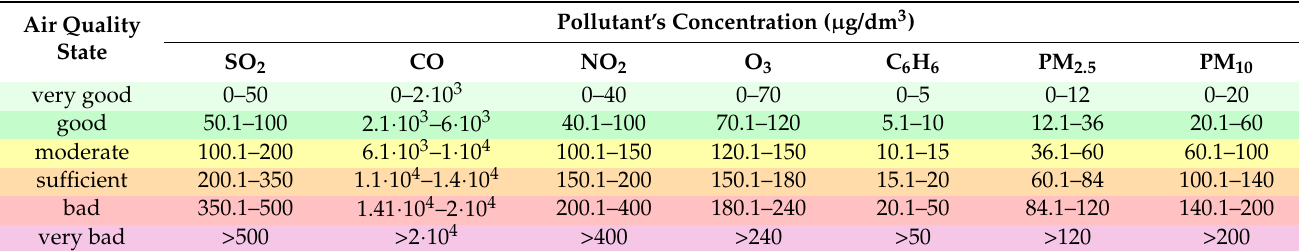
Table 1. Air quality according to the concentration of pollutants.